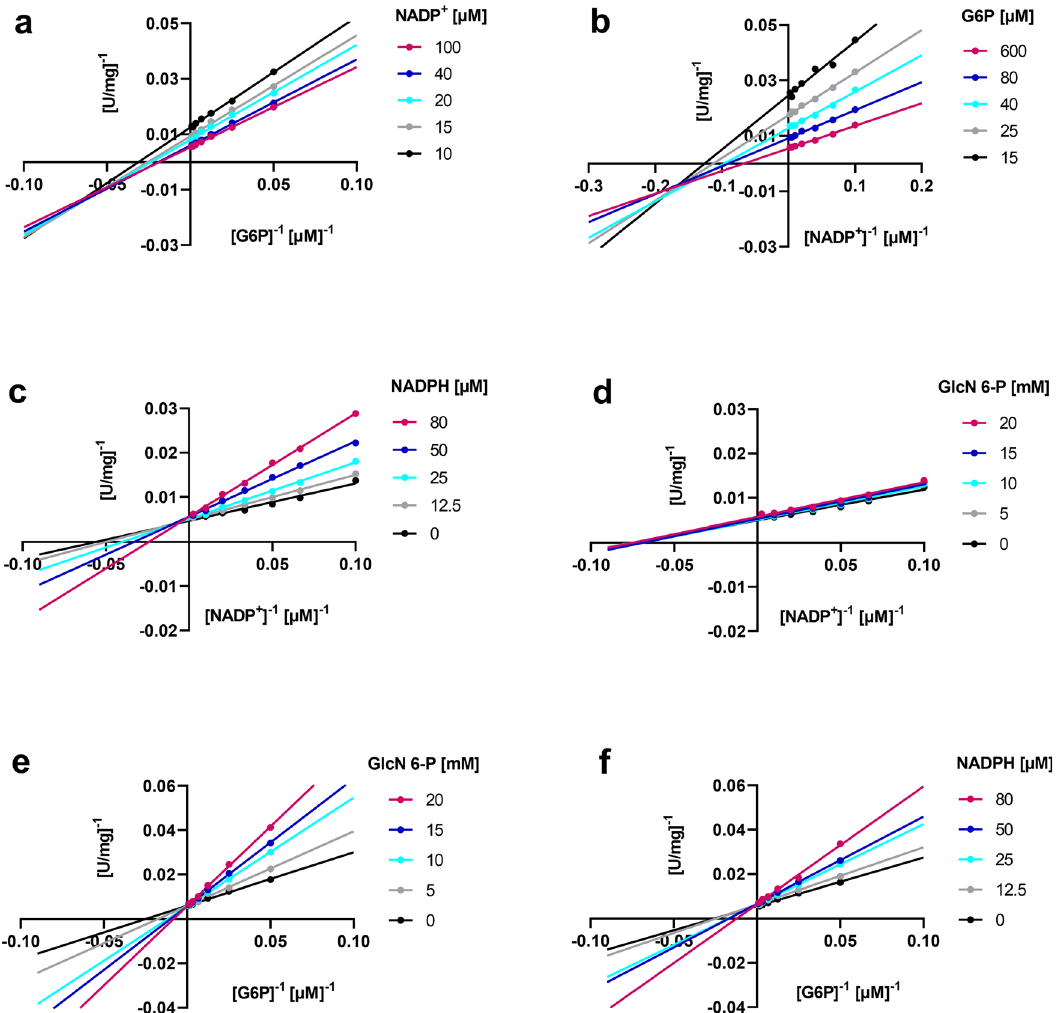
Fig. 7 Ld G6PD ’ s sequential binding mechanism for the substrates NADP + and G6P and inhibition by the product inhibitor NADPH and the dead-end inhibitor glucosamine 6-phosphate. a NADP + and b G6P, as well as c, f NADPH and d, e glucosamine 6-phosphate (GlcN 6-P) were titrated at various constant concentrations of the substrate G6P or cosubstrate NADP + . The primary double reciprocal plots of [U/100mg] − 1 against [G6P] − 1 and [NADP + ] − 1 , respectively, are shown. Plots a and b intercept left of the ordinate, indicating a sequential binding mode of the substrates. Plots c , e , and f intercept on the ordinate, indicating a competitive inhibition of NADPH against NADP + and G6P and of GlcN 6-P against G6P, but not against NADP + . d Representative graphs from three independent replications are